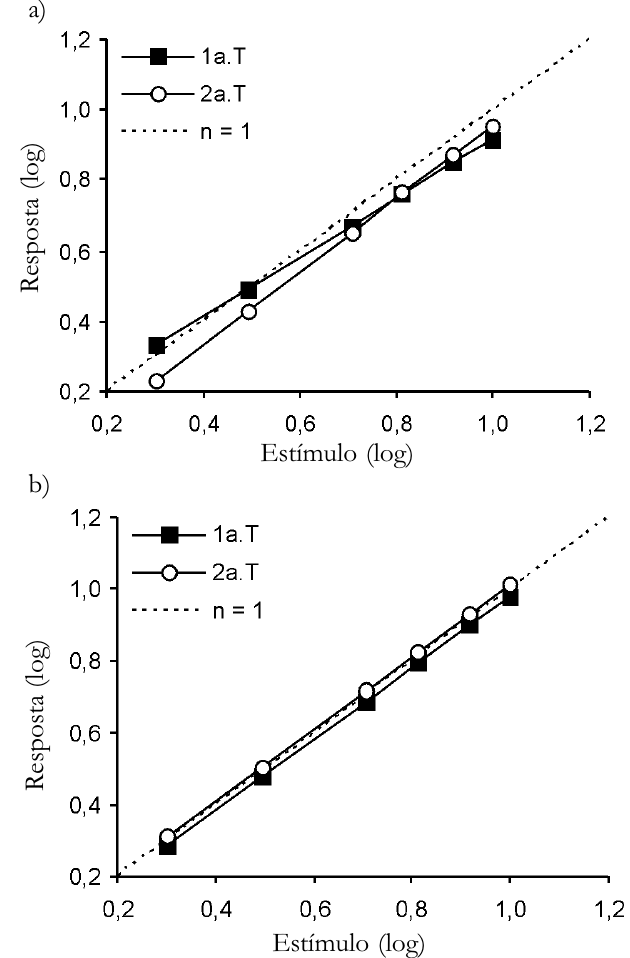
Figura 4. Valores mØdios do expoente nas duas sØries de tentativa para os participantes do grupo crian(cid:231)a (a) e grupo adulto (b). As linhas com quadrado representam a primeira tentativa, enquanto que as linhas com c(cid:237)rculos a segunda tentativa. A linha sem marcador representa o expoente igual